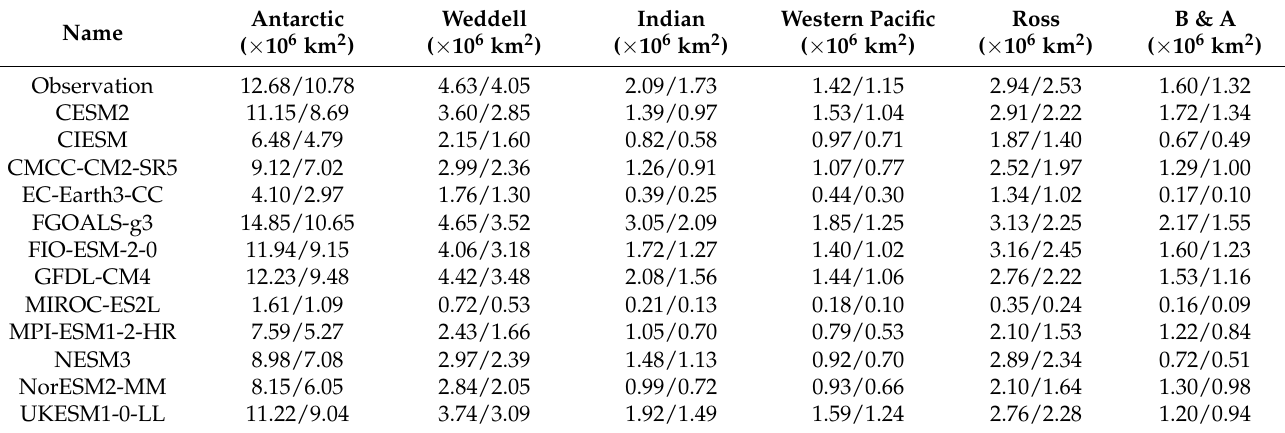
Table 2. Mean SIE/SIA over the period 2015–2021 for the observation and CMIP6 models in the whole Antarctic and five subregions.